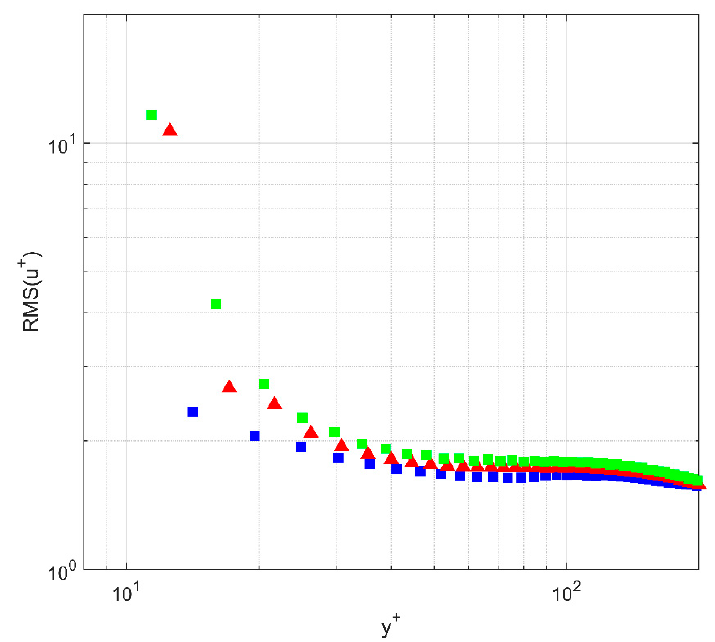
Figure 6. Carrier flow root mean square of stream-wise component of velocity in wall coordinates. Clear-water case compared to the fiber-laden case at low concentration C low , two aspect ratios k 1 (red triangles) and k 2 (green squares).